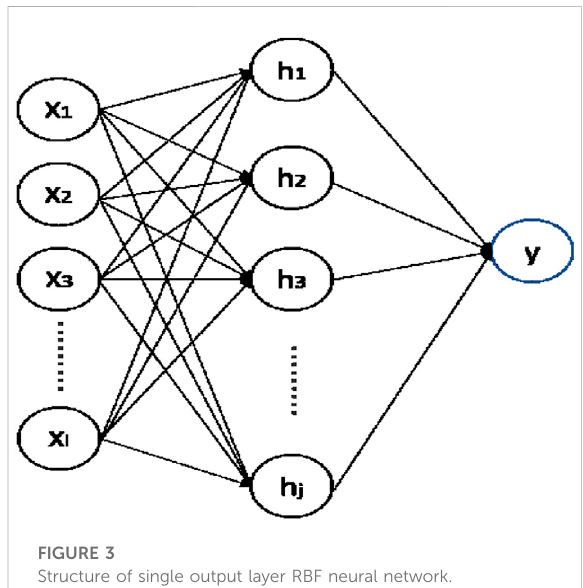
FIGURE 3 Structure of single output layer RBF neural